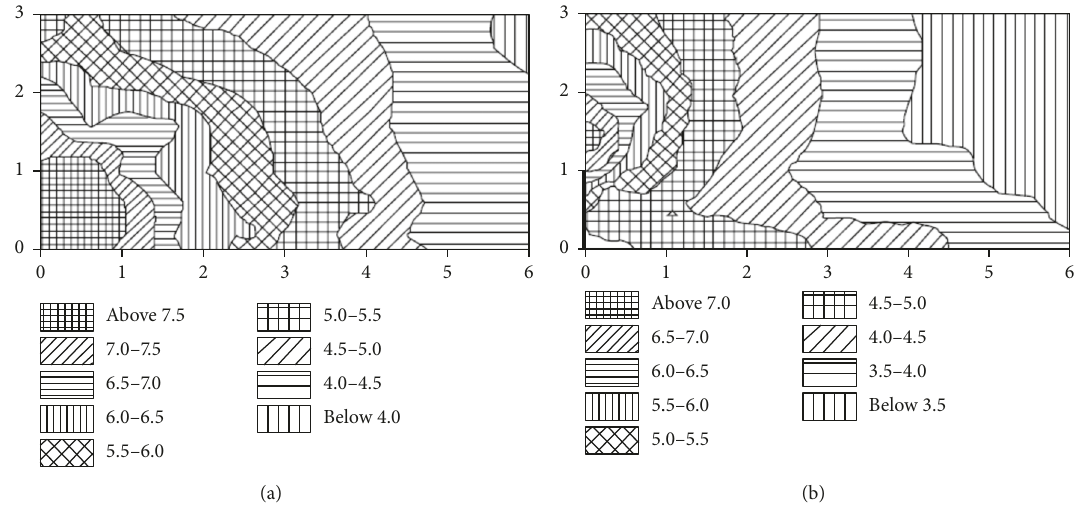
Figure 11: (a) Pressure contour map without wall; (b) pressure contour map with wall.